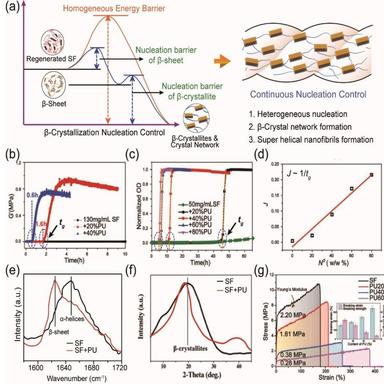
Schematic showing nucleation control and the effect of foreign substrates. (a) Homogeneous nucleation and the multistep nucleation. The multistep nucleation consists of two parts: β-sheet formation and β-crystallite formation, and can decrease the nucleation barrier so that crystallization of SF molecules is promoted. Nucleation control for the formation of these structures. Reproduced with permission . Copyright 2019, Wiley-VCH. The influence of polyurethane (PU) on the self-assembly process o